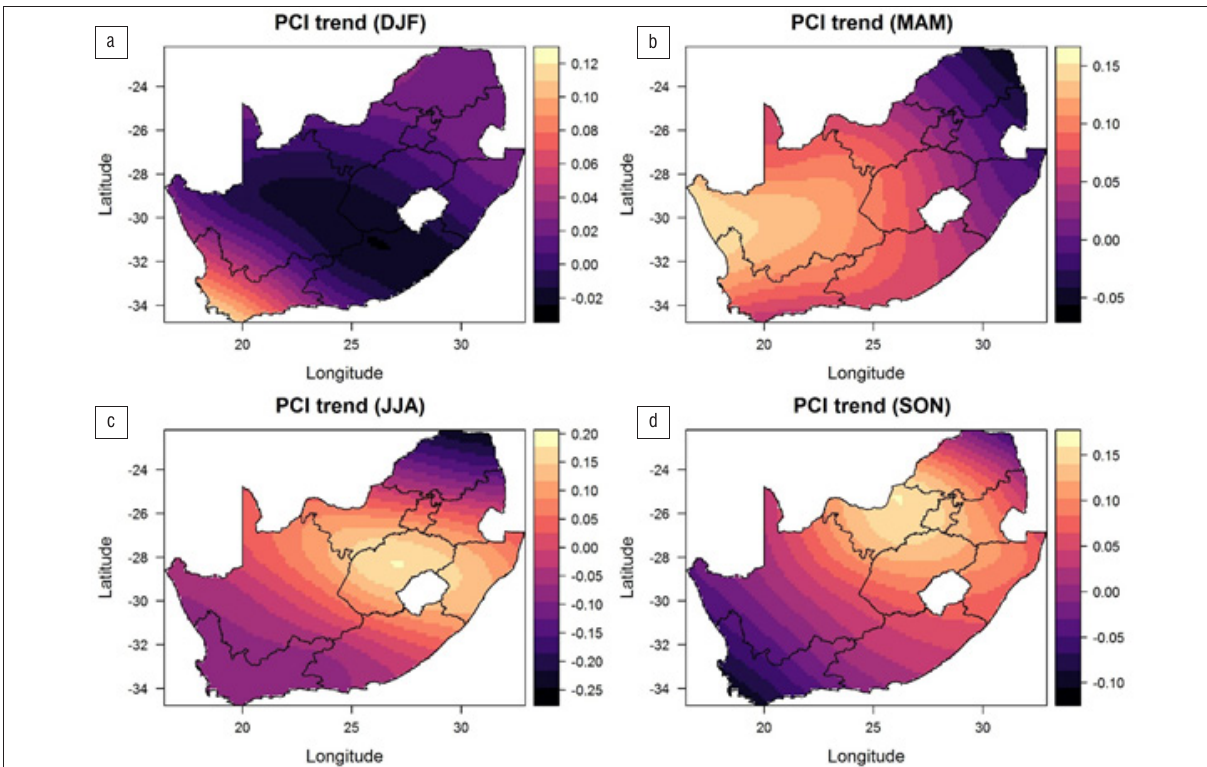
Figure 6 : Distribution of seasonal precipitation concentration index (PCI) trends for (a) December–January–February (DJF), (b) March–April–May (MAM), (c) June–July–August (JJA), (d) September–October–November